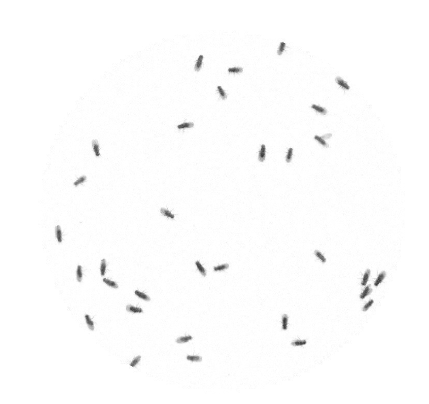
Figure 2. Resulting image from background subtraction followed by intensity reversal. The static arena part that belongs to the background was deleted. Only moving flies’ body and their wings remain in the resulting image.